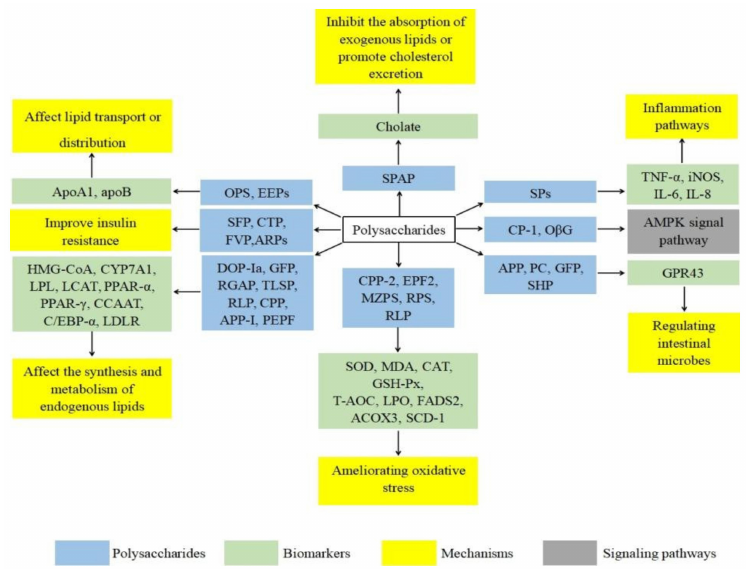
Figure 2. Polysaccharides and its various mechanisms for lowering blood